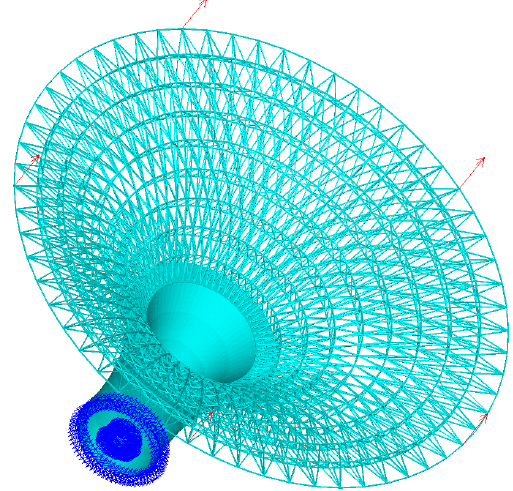
Figure 19. Illustrations of lattice structure generation for horn structure.